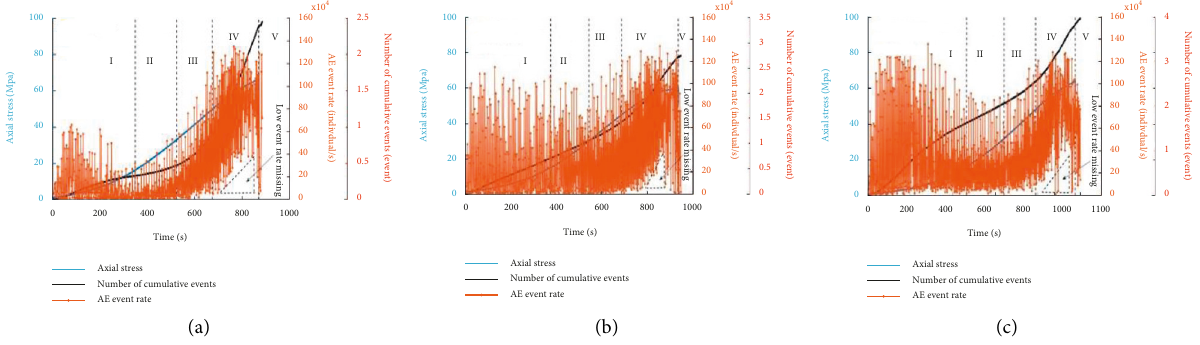
Axial stress Number of cumulative events AE event rate Figure 15: AE event rate, cumulative event number, and stress-time curve of yellow sandstone. (a) 20 cycles. (b) 30 cycles. (c) 40